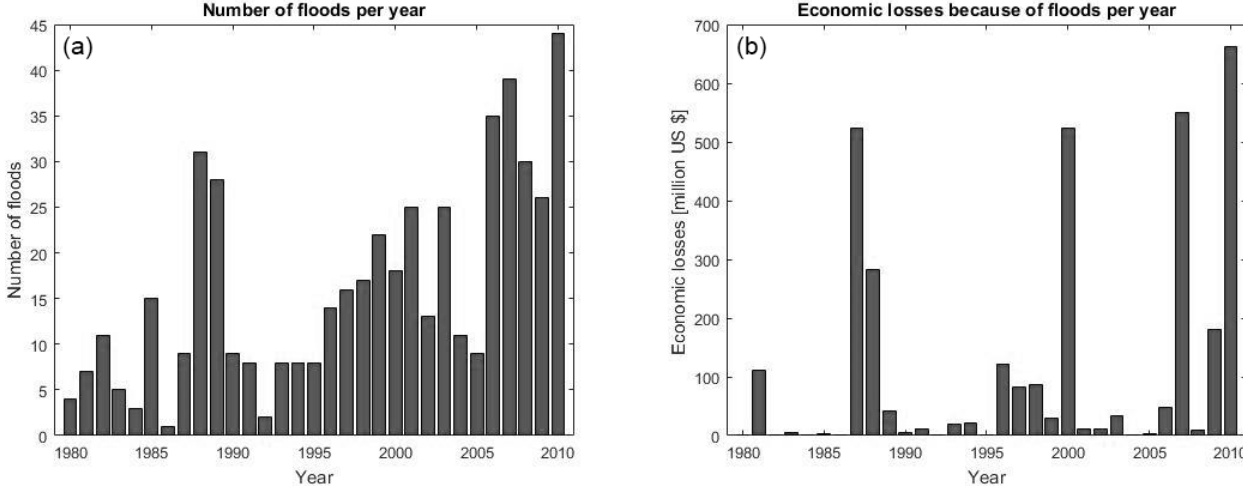
Figure 2. Number of floods per year that are analysed in this study (a) and economic losses in million USD per year caused by these floods (b) in sub-Saharan Africa between 1980 and 2010 (Munich Re, 2014).